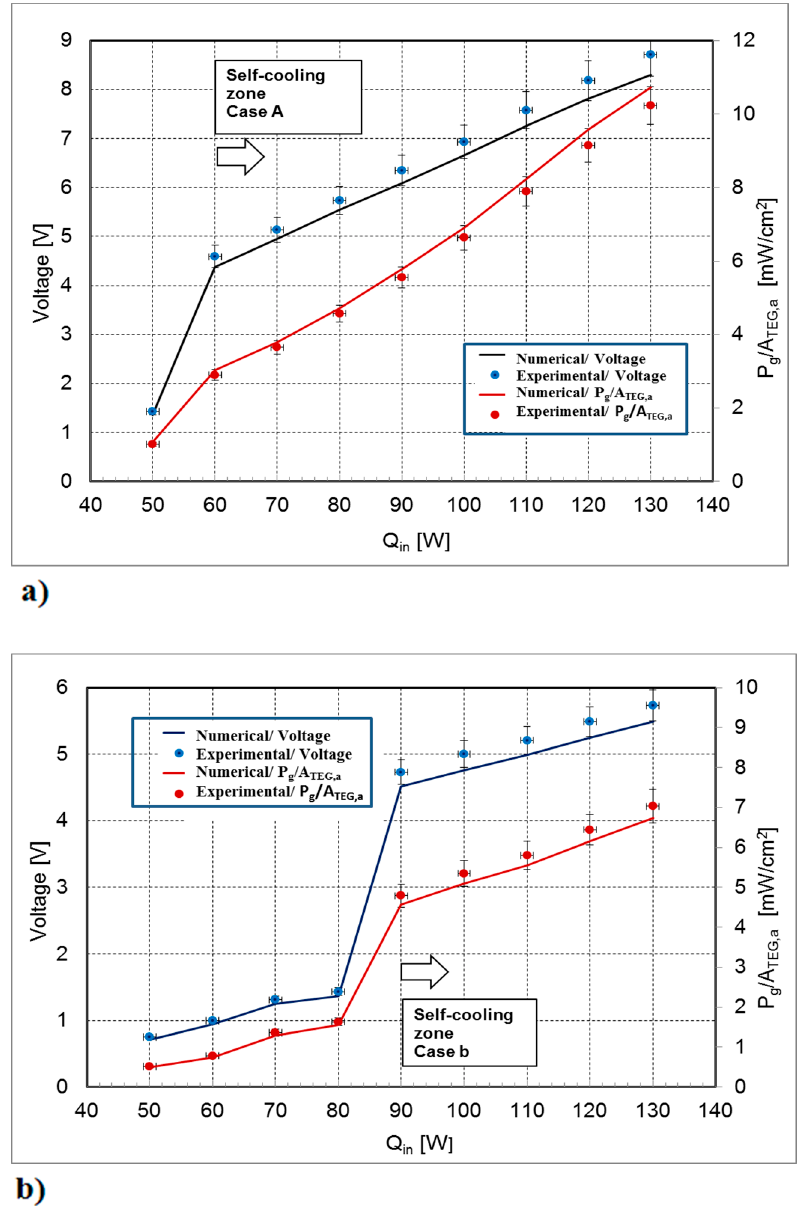
Figure 8. Total array voltage (V) and Power produced by TEG arrays per area of TEG arrays (PTEG/ATEG, a) for ( a ) case A and ( b ) case B.